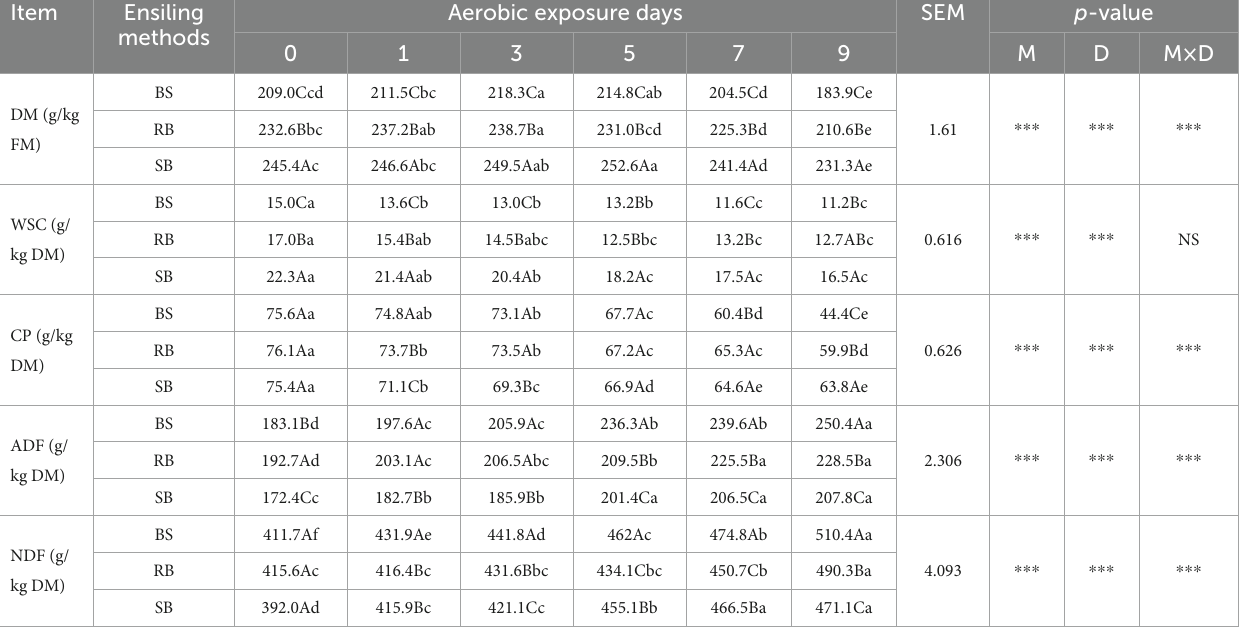
TABLE 1 Effect of different ensiling methods on chemical compositions of WPCS during aerobic exposure. Item